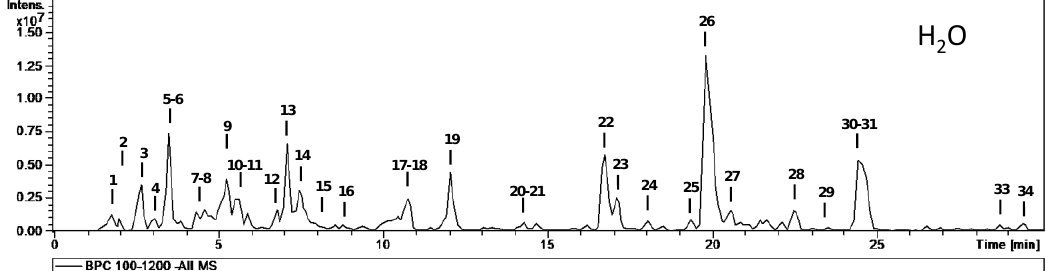
Figure 1. HPLC-ESI-MS n base peak chromatograms of the aqueous extract.